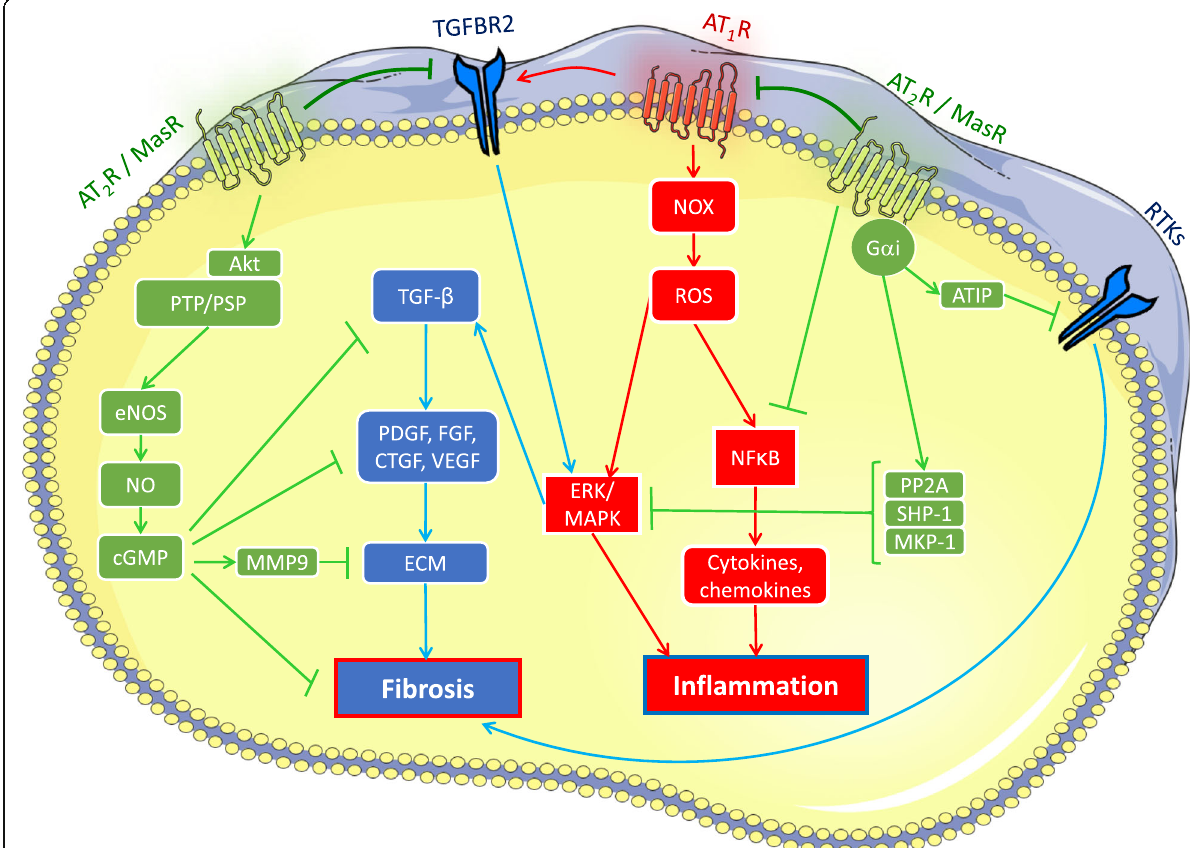
Fig. 2 Anti-inflammatory and anti-fibrotic pathways mediated by activated AT 2 R and/or MasR. The AT 2 R and MasR are expressed in the cell as monomers, homodimers and AT 2 R-MasR heterodimers (Leonhardt et al. 2017) and their downstream pathways are largely similar, making it often impossible to distinguish between them. During infection the AT 1 R becomes activated initiating inflammatory processes via NF κ B and MAPK. Prolonged activation of AT 1 R may initiate pro-fibrotic processes with TGF β as a key molecule. Agonist-mediated stimulation of AT 2 R or MasR inhibits activation of NF κ B and MAPK resulting in anti-inflammation. For the anti-fibrotic action the inhibition of receptor tyrosine kinase activity by dephosphorylation on the one hand, and activation of cGMP on the other hand, plays a crucial role. In addition, heterodimerization between AT 1 R and AT 2 R or MasR inhibits detrimental effects mediated by AT 1 R. Blue lines: pro-fibrotic pathways; red lines: pro-inflammatory pathways; green lines: anti-inflammatory or anti- fibrotic pathways. AT 2 R / MasR: angiotensin II type 2 receptor or Mas receptor or AT 2 R-MasR heterodimers; TGFBR2: transforming growth factor beta receptor II; AT 1 R: angiotensin II type 1 receptor; RTKs: receptor tyrosine kinases; Akt: protein kinase B; PTP: protein tyrosine phosphatase; PSP: protein serine/threonine phosphatase; eNOS: nitric oxide synthase 3; NO: nitric oxide; cGMP: cyclic guanosine monophosphate; MMP9: matrix metallopeptidase 9; TGF β : transforming growth factor beta; PDGF: platelet-derived growth factor; FGF: fibroblast growth factor; CTGF: connective tissue growth factor; VEGF: vascular endothelial growth factor; ECM: extracellular matrix; ERK: extracellular signal-regulated kinases; MAPK: mitogen-activated protein kinase; NOX: NADPH oxidase; ROS: reactive oxygen species; NF κ B: nuclear factor kappa B; G α i: G protein alpha i subunit; ATIP: AT 2 R-interacting proteins/microtubule- associated scaffold proteins; PP2A: protein phosphatase 2A; SHP-1: Src homology region 2 domain-containing phosphatase-1; MKP-1: MAPK Phosphatase 1. The pathways are based on: Unger et al. 2015; Sumners et al. 2019; Zhang et al. 2014; Leonhardt et al. 2017; Chappell and Al Zayadneh